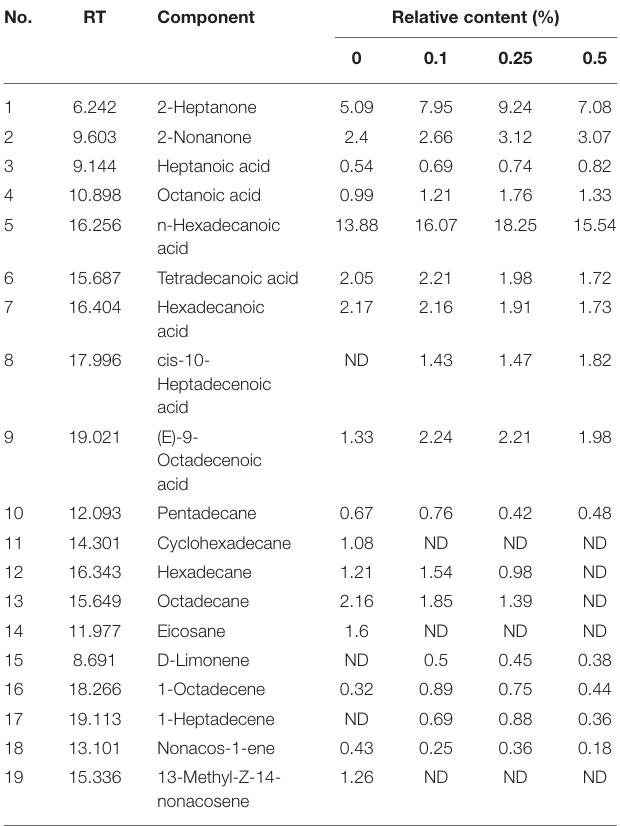
TABLE 2 | Flavor components in yogurt identified by GC-MS